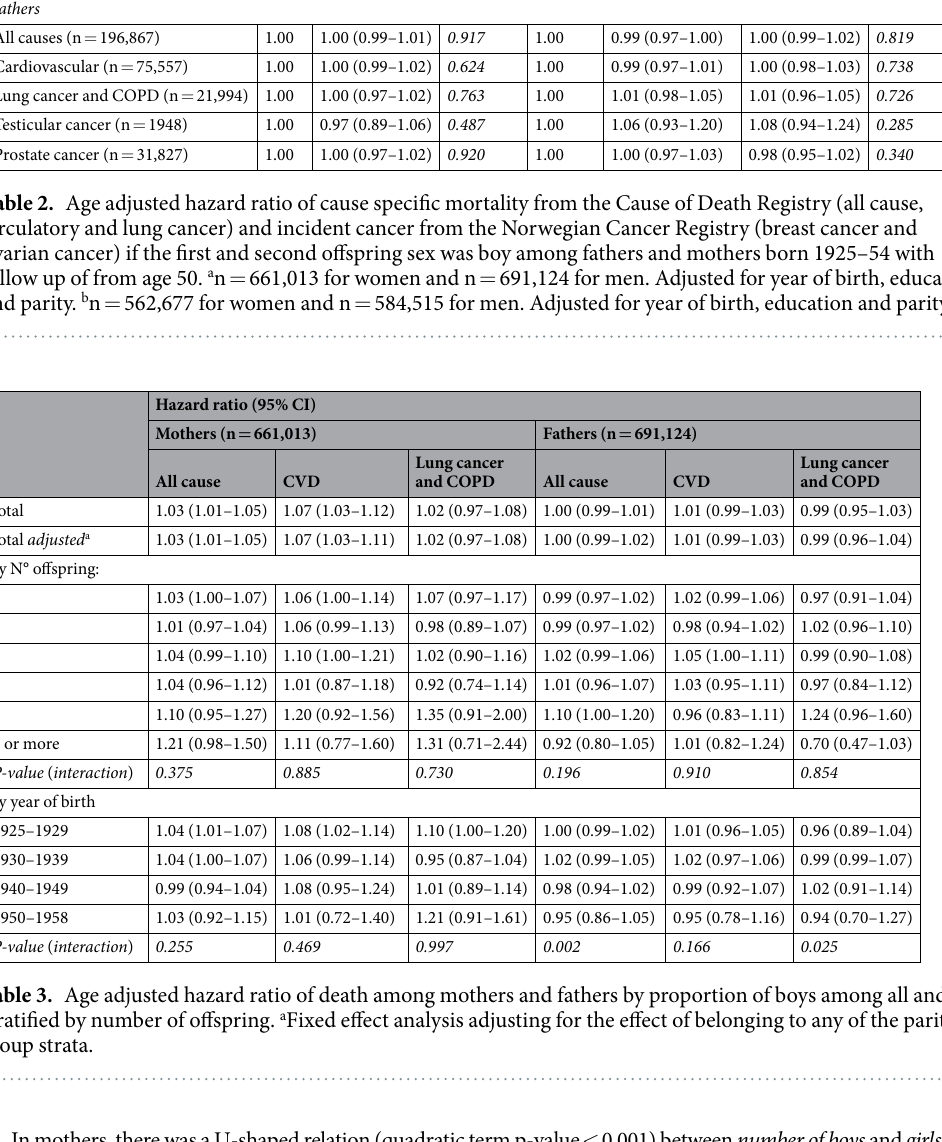
Table 3. Age adjusted hazard ratio of death among mothers and fathers by proportion of boys among all and stratified by number of offspring. a Fixed effect analysis adjusting for the effect of belonging to any of the parity group